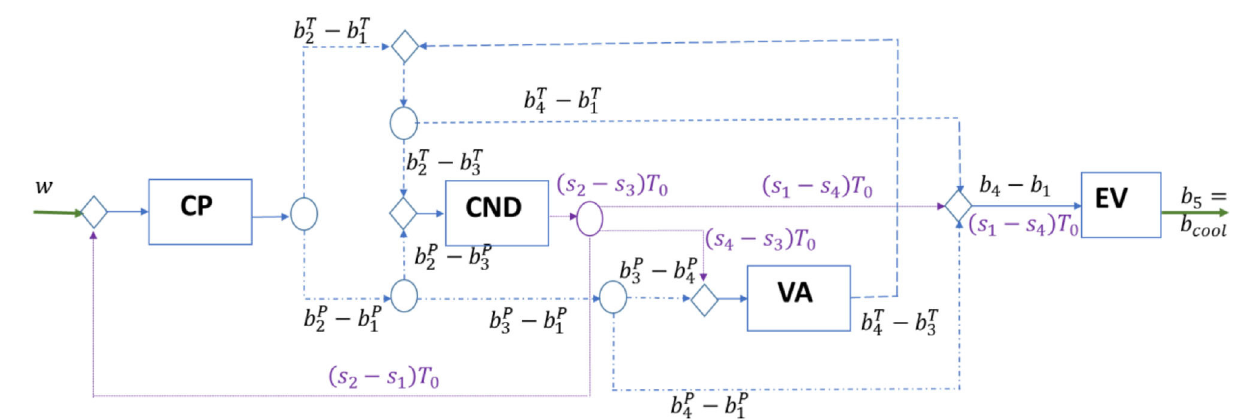
FIGURE 6 | E&S model approach with exergy